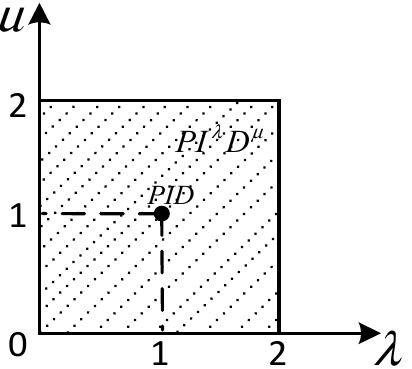
Figure 12. Fractional-order PID control plane diagram. Figure 13 is the FOPID control system model. are the expected input, controller output, and system output, respectively, and is the controlled ob- ject.